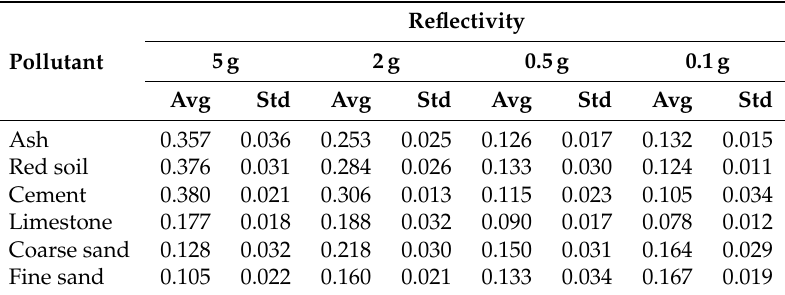
Table 5. Results for the reflectivity in the infrared spectrum.